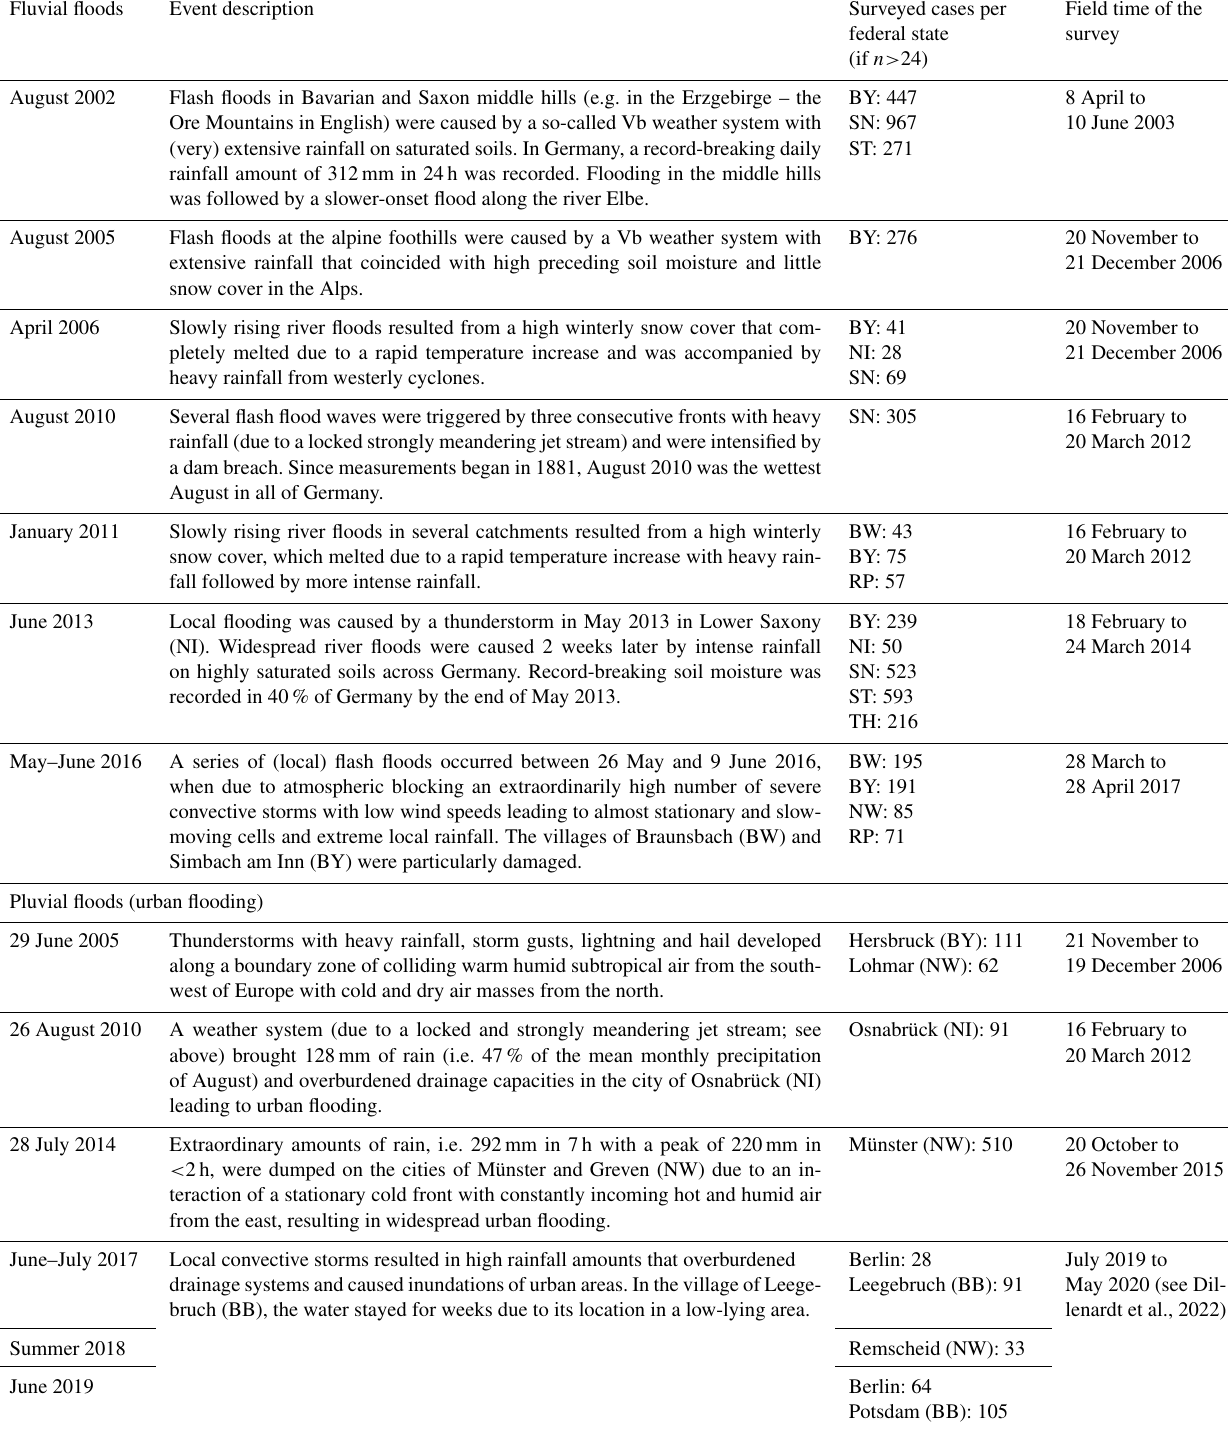
Table 1. Overview of recent damaging flood events in Germany and number of survey participants per federal state (compiled from Kienzler et al., 2015; Rözer et al., 2016; Spekkers et al., 2017; Thieken et al., 2016, 2017, 2022; Dillenardt et al., 2022; abbreviations of the federal states – BB: Brandenburg; BW: Baden-Württemberg; BY: Bavaria; NI: Lower Saxony; NW: North Rhine-Westphalia; RP: Rhineland-Palatinate; SN: Saxony; ST: Saxony-Anhalt; TH: Thuringia; see Fig. 1 for geographic